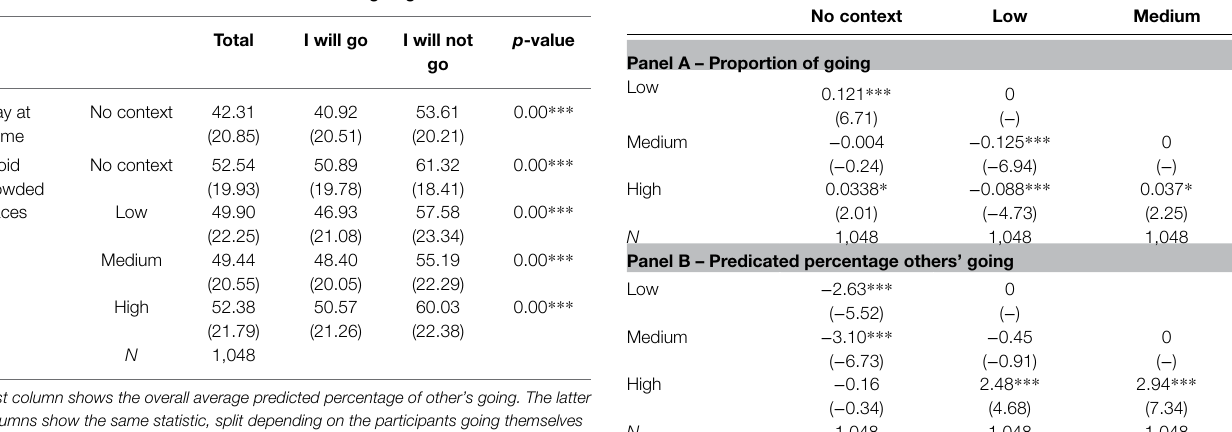
TABLE 3 | Statistics on the expectations of others going within each condition. Predicted ratios of others’ going